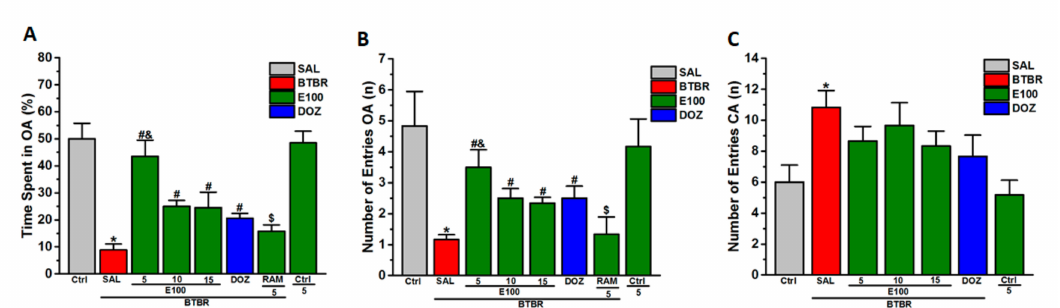
Figure 3. E ff ects of E100 and DOZ pretreatment on anxiety levels and locomotor activity in BTBR mice in EPMT test. BTBR mice (red) demonstrated significant elevated anxiety-related behavior and hyperactivity compared to Ctrl mice (gray). Subchronic (21 days) administration of E100 (5, 10 or 15 mg / kg, i.p. in green) or DOZ (1 mg / kg, i.p., in blue) attenuated ( A ) the decreased percentage of time spent exploring the open arms of the EPMT, ( B ) the decreased frequency of open arms entries and ( C ) failed to decrease the increased number of visits into the closed arms in BTBR mice. E ff ects of subchronic (21 days) systemic co-injection of RAM (10 mg / kg, i.p.) on the E100 (5 mg)-provided elevation of percentage of ( A ) time spent in open arms or ( B ) frequency of entries into open arms of BTBR mice were evaluated in EPMT. Data are expressed as the mean ± SEM (n = 6). * p < 0.05 compared to saline treated Ctrl mice. # p < 0.05 compared to saline treated BTBR mice. & p < 0.05 compared to E100 (10 or 15 mg)-treated BTBR mice. $ p < 0.05 vs. E100 (5 mg)-treated BTBR